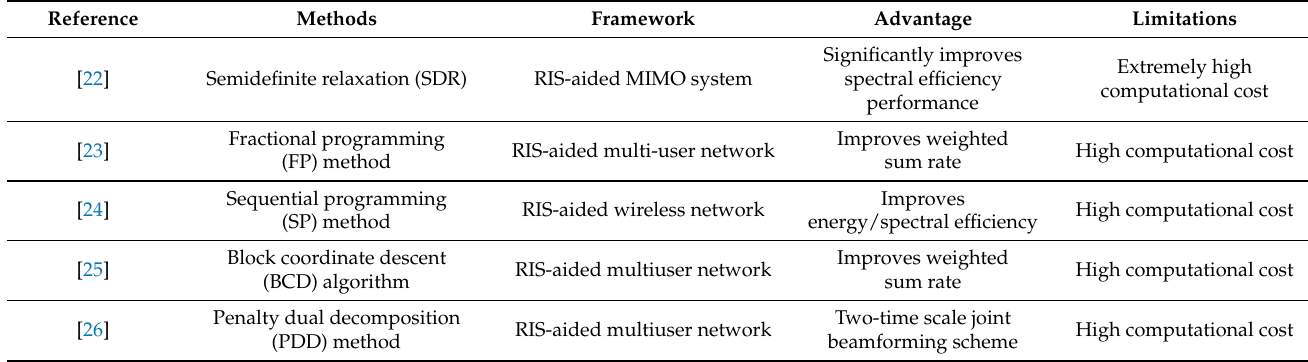
Table 1. A Summary of the existing solutions with pros and cons.